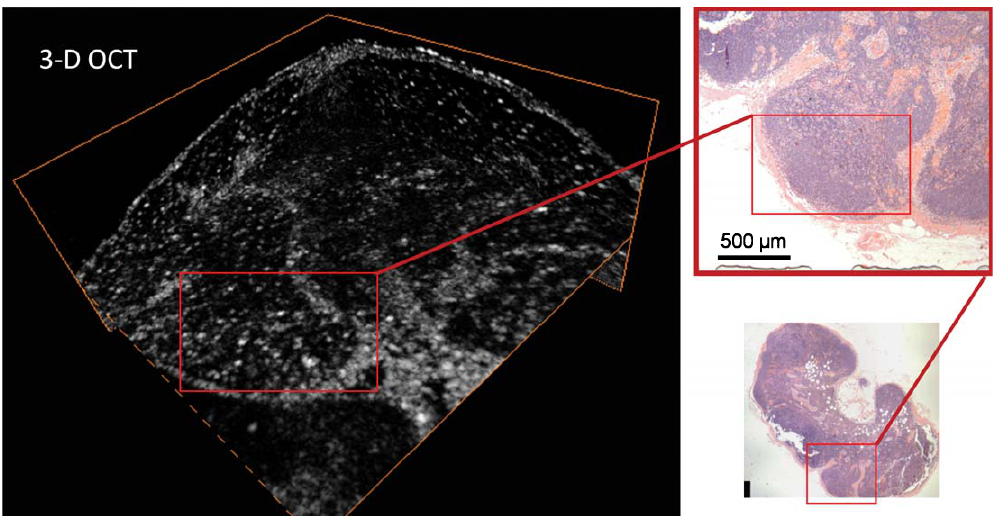
Fig. 8. 3-D OCT image and corresponding histology of a normal sentinel lymph node. The normal lymph node shows a clear capsule that is easily differentiated from the low-scattering cortex. The OCT image correlates to the regions in the histology that are highlighted by the red boxes. The volume of the 3-D OCT dataset is 5 × 5 × 1.7mm 3 . Figure used with permission from